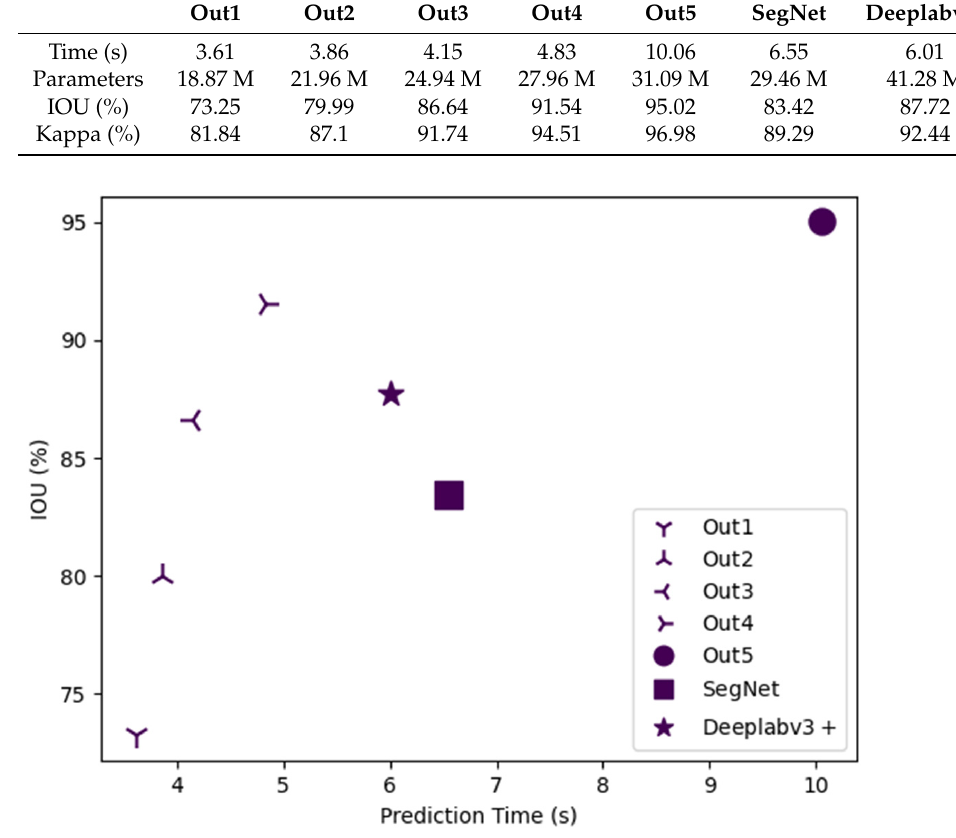
Table 6. Comparison of results of deep supervision and other models. Out1